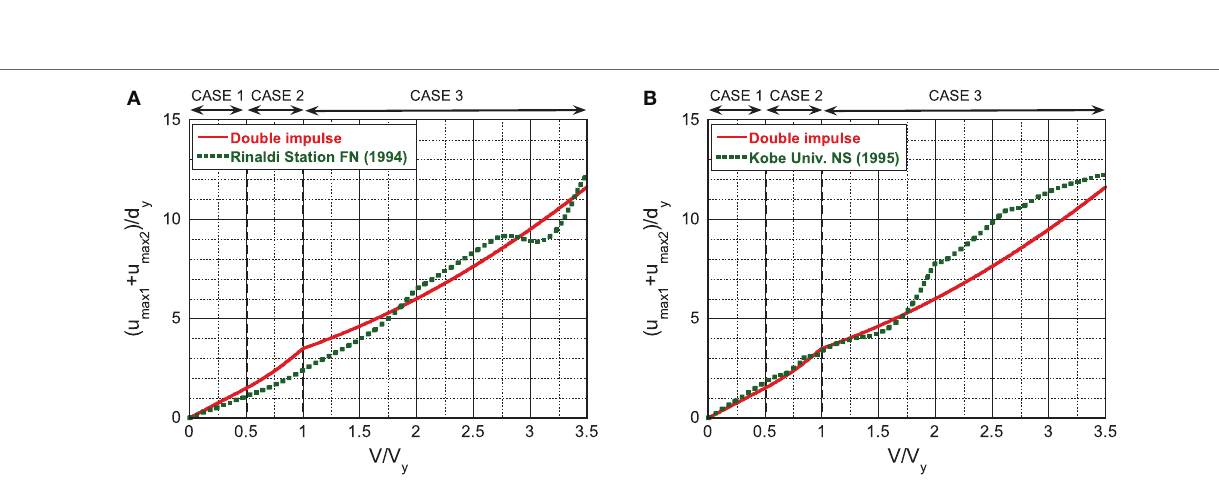
FigUre 14 | Modeling of part of pulse-type recorded ground motion into the corresponding one-cycle sinusoidal input: (a) rinaldi station fault- normal component during the northridge earthquake in 1994 and (B) Kobe University ns component (almost fault-normal) during the hyogoken- nanbu (Kobe) earthquake in